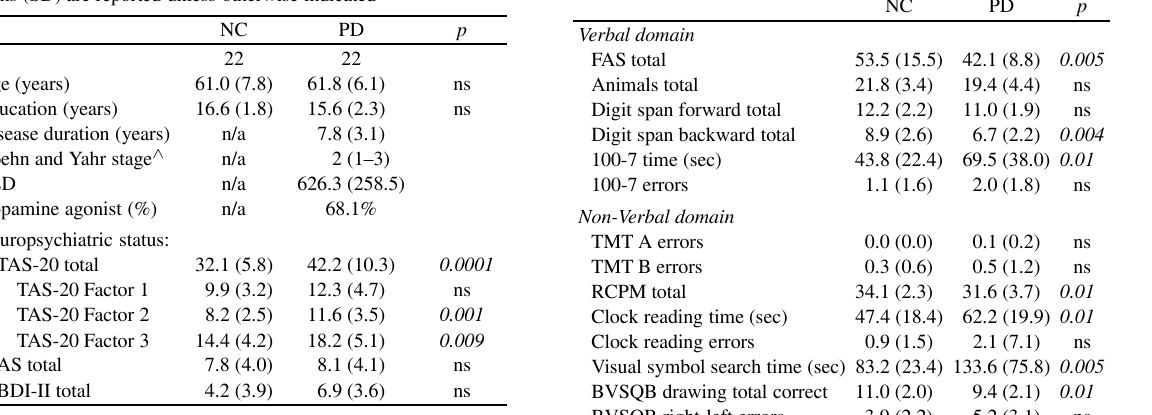
Table 1 Demographic and clinical characteristics of PD and NC participants.